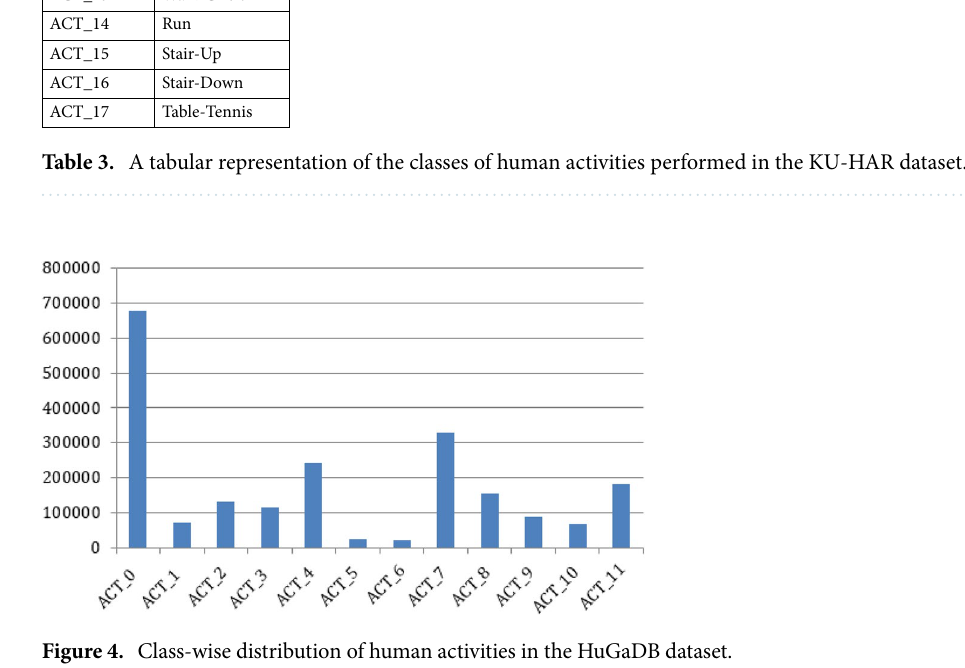
Figure 4. Class-wise distribution of human activities in the HuGaDB dataset.